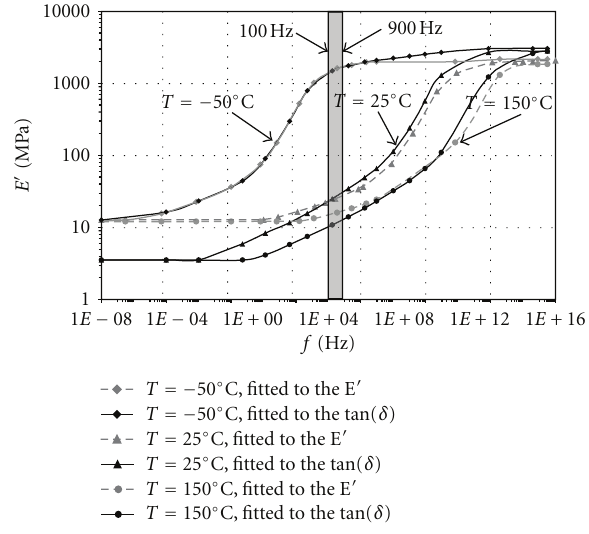
Figure 9: Storage modulus versus frequency curves of EPDM v2 at three di ff erent temperatures in case of two di ff erent 40-term generalized Maxwell-models (strain amplitude = 0.01%).